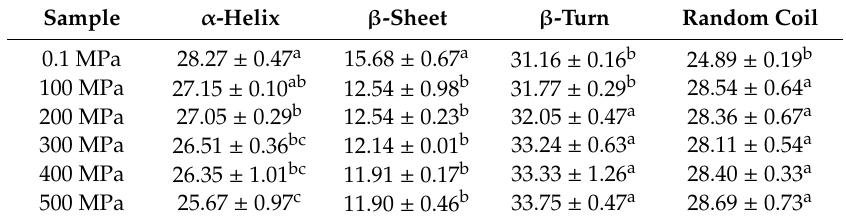
Table 2. The secondary structure content estimated from deconvoluted FTIR spectra of control and HP treated oyster proteins.